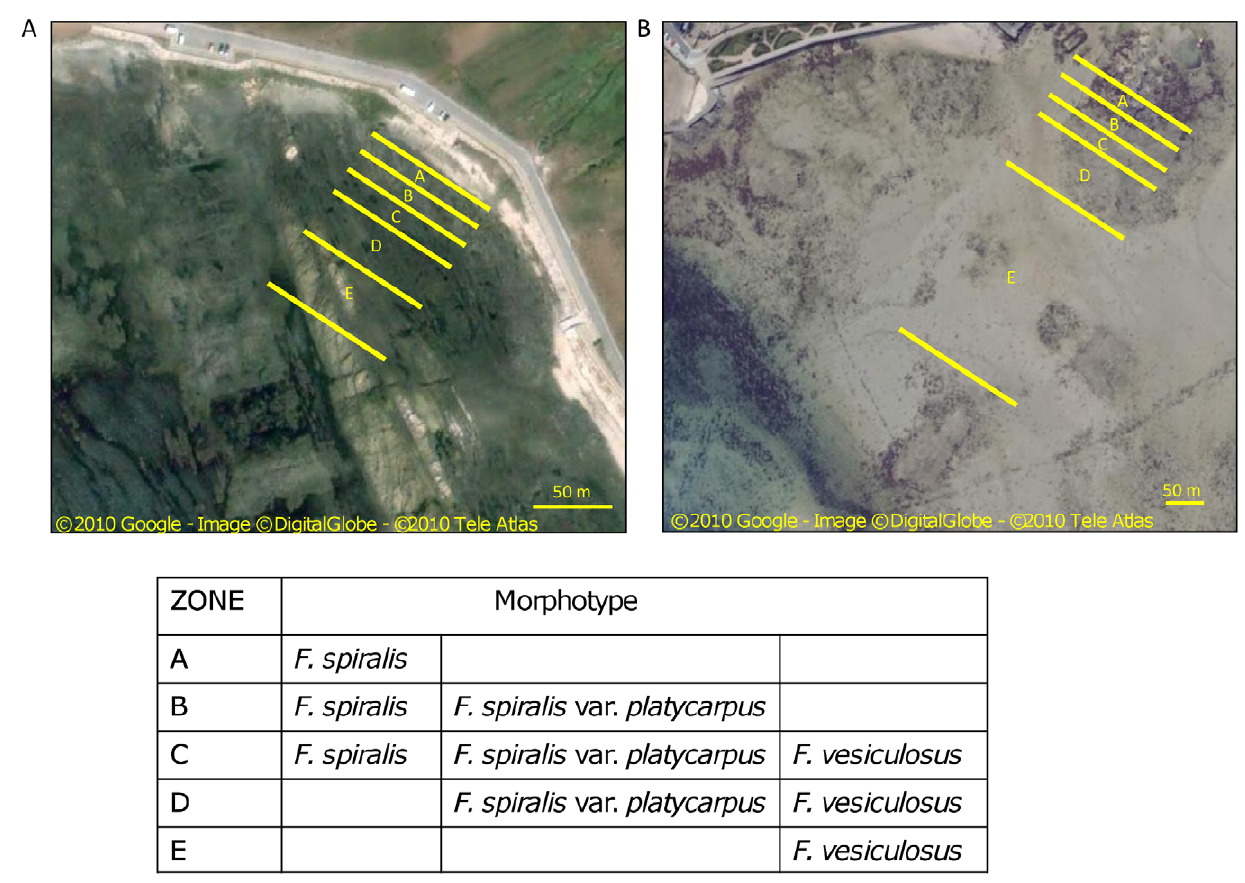
Figure 1. Zonation in Fucus zone. Division of Fucus zone into five areas based on distribution of the three morphotypes at (A) Viana, Portugal and (B) Roscoff, France.